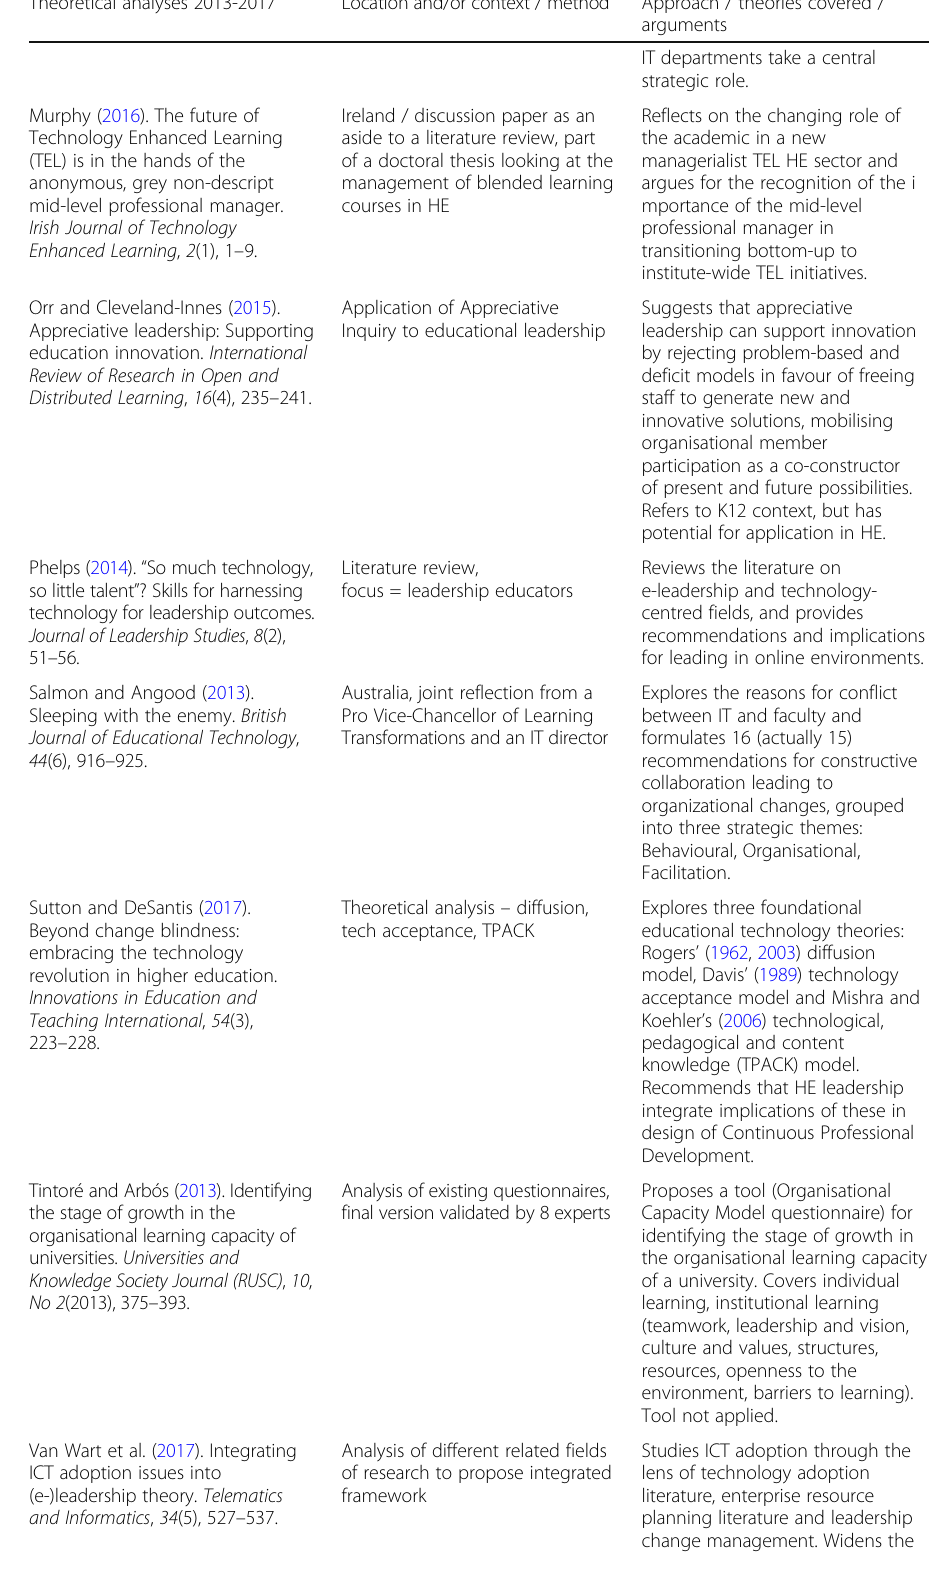
Table 3 Results: Theoretical analyses